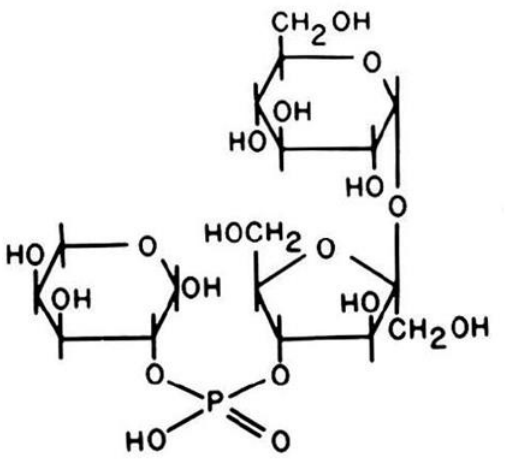
Figure 3. Agrocinopine A (provided by Maarten Ryder).